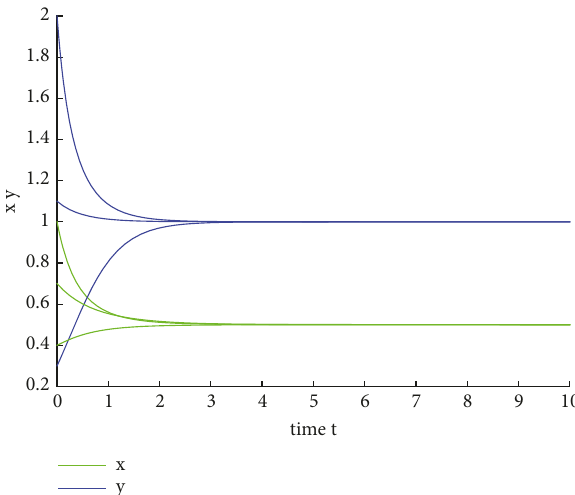
Figure 1: Solutions (𝑥(𝑡),𝑦(𝑡)) of system (21) with the initial conditions (𝑥(0),𝑦(0)) = (1, 0.3) , (0.4,2) , and (0.7,1.1) . Figure 2: Solutions